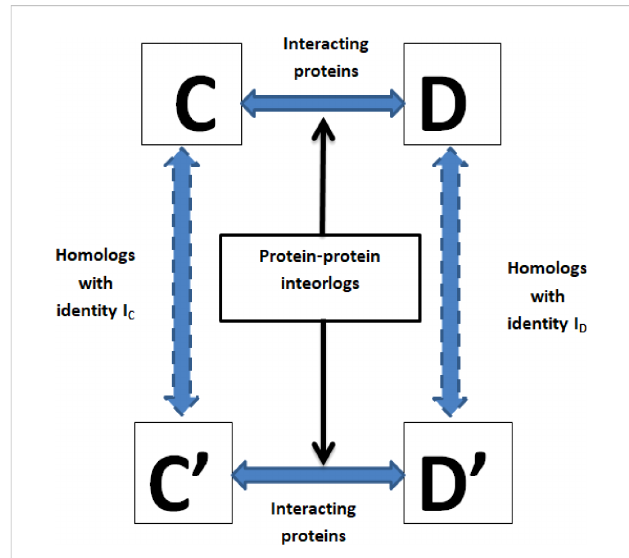
FIGURE 2 A schematic presentation of the interolog model for protein – protein interaction prediction. Here, (C, D) are two interacting proteins, and (C ’– D ’ ) are the proteins among which interaction needs to be predicted. Protein C ’ is homologous to (C, D ’ ) is homologous to (D), then (C ’ , D ’ ) are likely to interact.